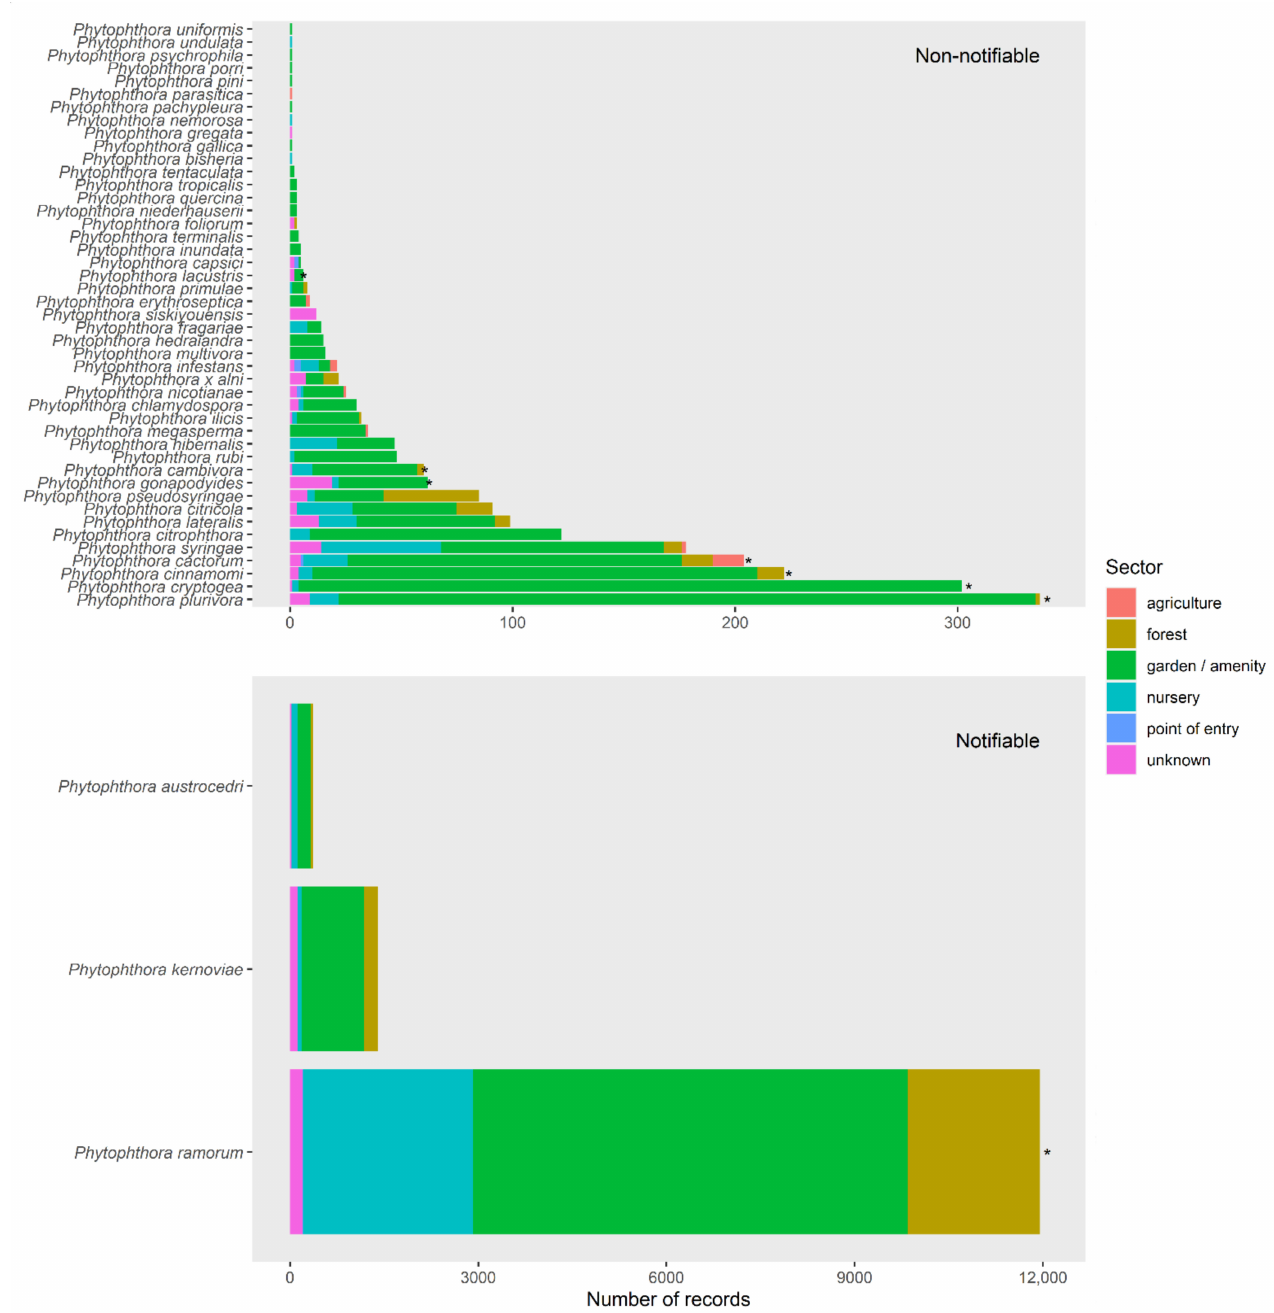
Figure 10. Number of times each Phytophthora species has been recorded in the UK, in points of entry, the nursery, garden, forest or agricultural sectors for notifiable (lower graph) and non-notifiable (upper graph)